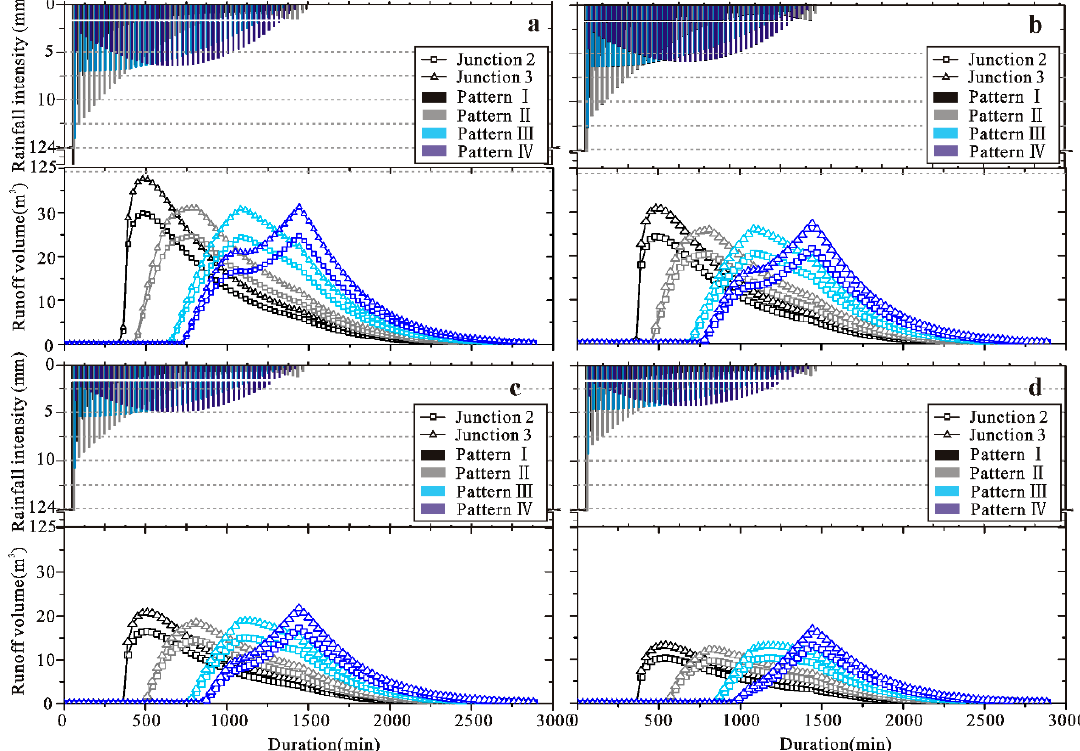
Figure 8. Runoff volumes of Junction 2 and Junction 3. ( a – d ) The rainfall intensity (upper) and runoff volume (lower) at the frequencies of 1%, 2%, 5%, and 10% in Xiongmao Gully.